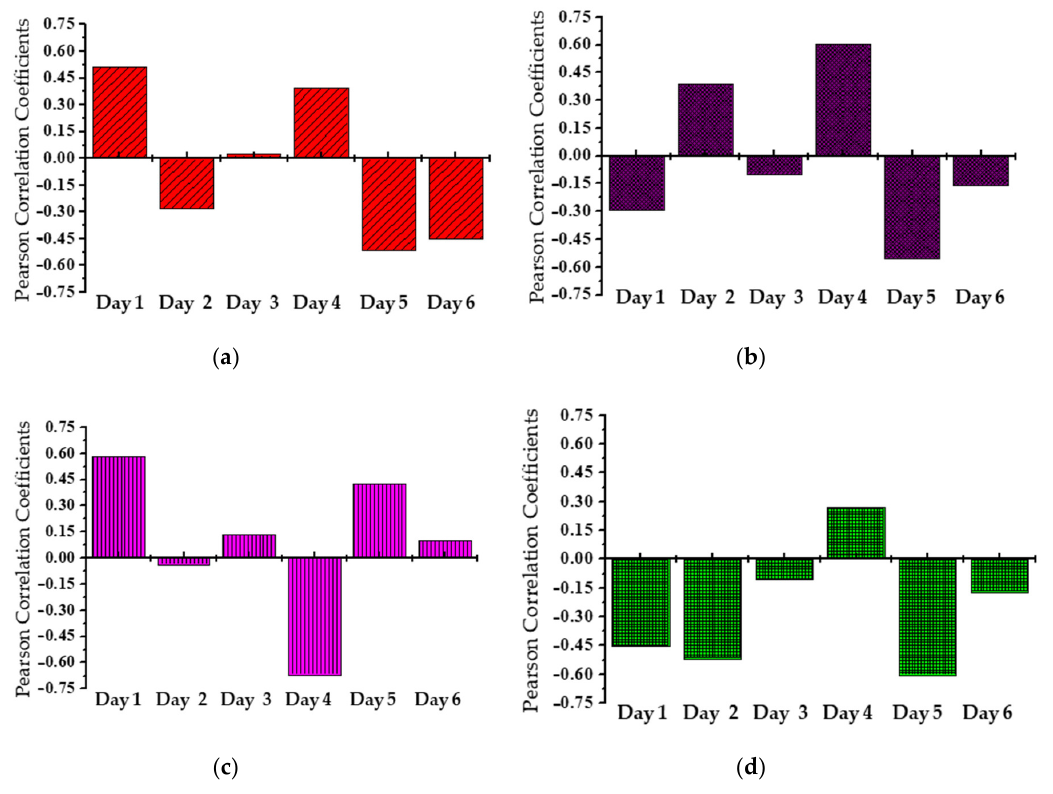
Figure 1. Correlation coefficients between photovoltaic (PV) power and weather variables: ( a ) average temperature, ( b ) rain amount, ( c ) daylight hours, and ( d ) cloud cover.